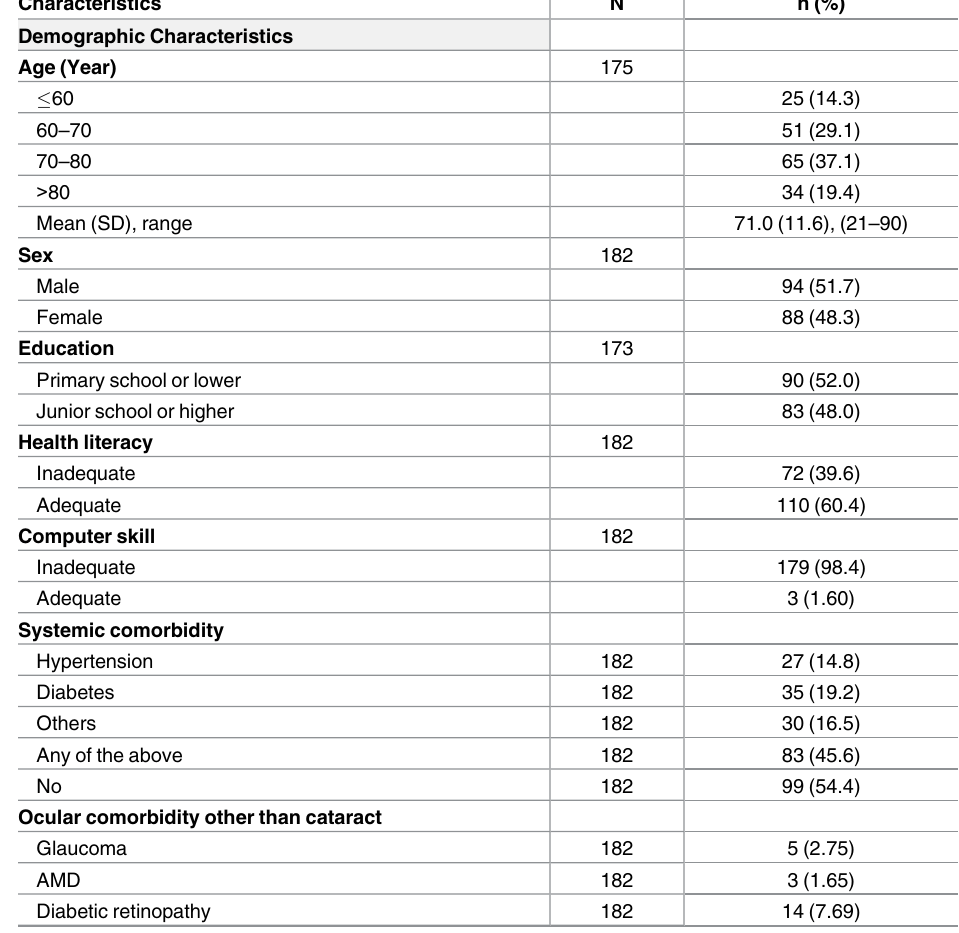
Characteristics N n (%) Demographic